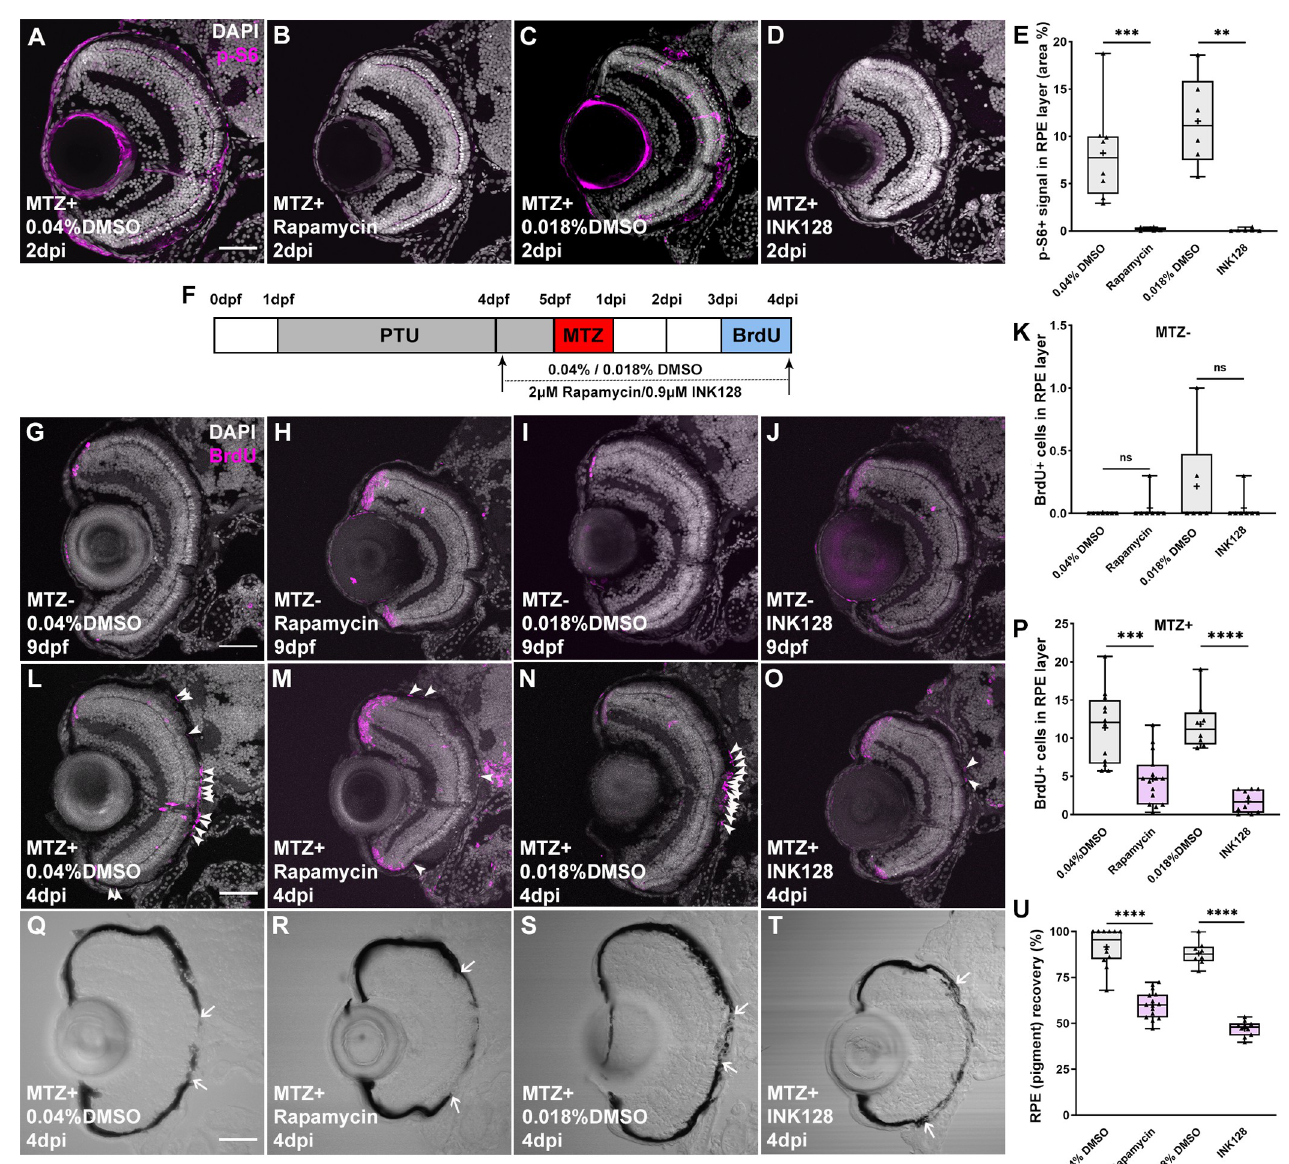
Fig 2. Pharmacological inhibition of mTOR activity impairs RPE regeneration. (A-D) Immunofluorescent images of p-S6 staining on transverse cryosections from MTZ + DMSO-, rapamycin- or INK128-treated larvae at 2dpi. Nuclei (white), p-S6 (magenta) (E) p-S6 levels in the RPE layer were significantly decreased in rapamycin-treated and INK128-treated larvae when compared with DMSO-treated controls. (F) Schematic of the experimental paradigm showing the timeline for chemical treatments and ablation. (G-J) Immunofluorescent images of BrdU staining on transverse cryosections from MTZ - DMSO-, rapamycin- and INK128-treated larvae at 9dpf and (L-O) from MTZ + DMSO-, rapamycin- or INK128 -treated larvae at 4dpi. White arrowheads indicate BrdU + cells in the RPE layer. Nuclei (white), BrdU (magenta). (K) Quantification of BrdU + cells in the MTZ - RPE layer showed no significant differences between DMSO-treated and inhibitor-treated larvae. (P) Quantification of BrdU + cells in the RPE layer showed significantly fewer BrdU+ cells in MTZ + rapamycin- and INK128-treated larvae when compared to DMSO-treated controls. (Q-T) Brightfield images of cryosections from MTZ + DMSO-, rapamycin- or INK128-treated larvae at 4dpi. White arrows indicate the edges of pigment recovery. (U) Quantification of percent RPE recovery showed a significant impairment in pigment recovery in rapamycin- or INK128-treated larvae. p-values: �� � 0.01, ��� � 0.001, and ���� � 0.0001. Statistical information can be found in S9 Table. Dorsal is up and distal is left. Scale bar = 50 μ